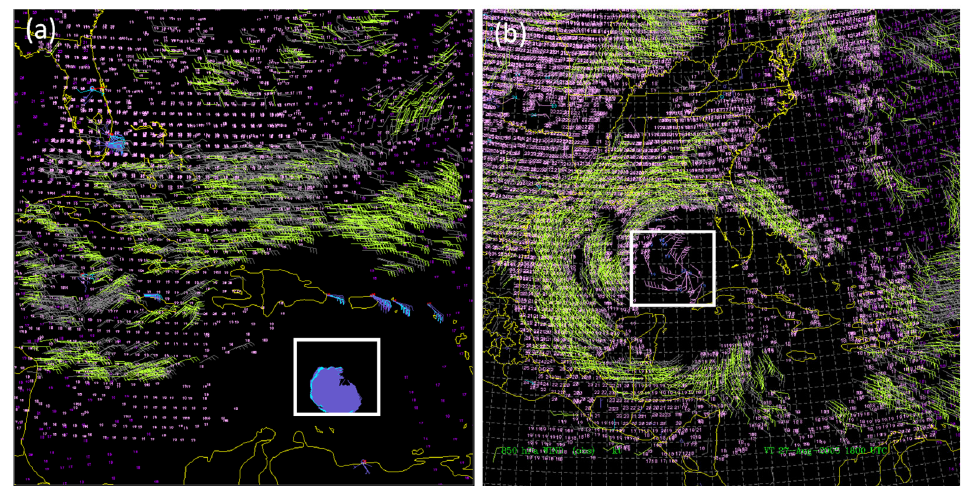
Figure 3. Observation data for Hurricanes ( a ) Dennis and ( b ) Katrina used in this study. The pink, red, green, and blue colors indicate the Geostationary Operational Environmental Satellite/Polar Operational Environmental Satellites soundings, Aircraft Communications Addressing and Reporting System (ACARS) data, winds from the Cloud Motion Vector Sensor (CMVS), and Doppler radar data, respectively. The outer and inner boxes indicate the mother and nested domain in the Hurricane Research System coupled with the Hurricane Local Analysis Prediction System (HRS/HLAPS), respectively.